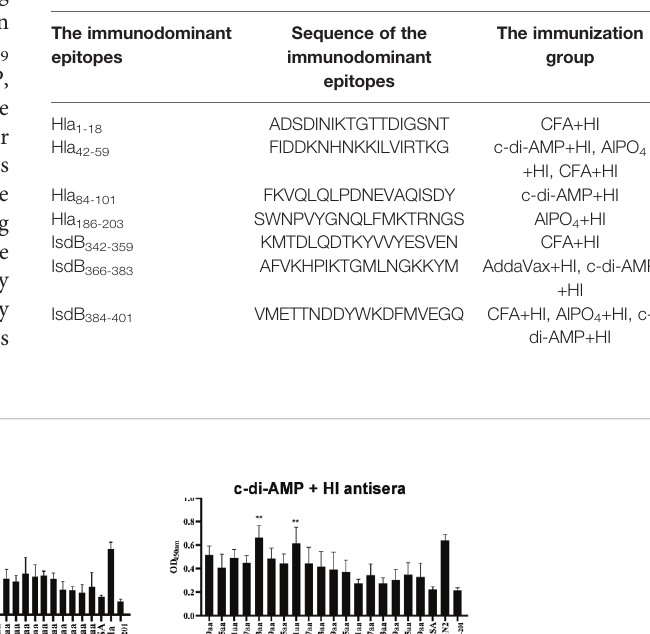
Figure 3 , seven epitopes (Hla 1-18 , Hla 42-59 , Hla 84-101 , Hla 186-203 , IsdB 342-359 , IsdB 366-383 and IsdB 384-401 ) were identi fi ed with strong